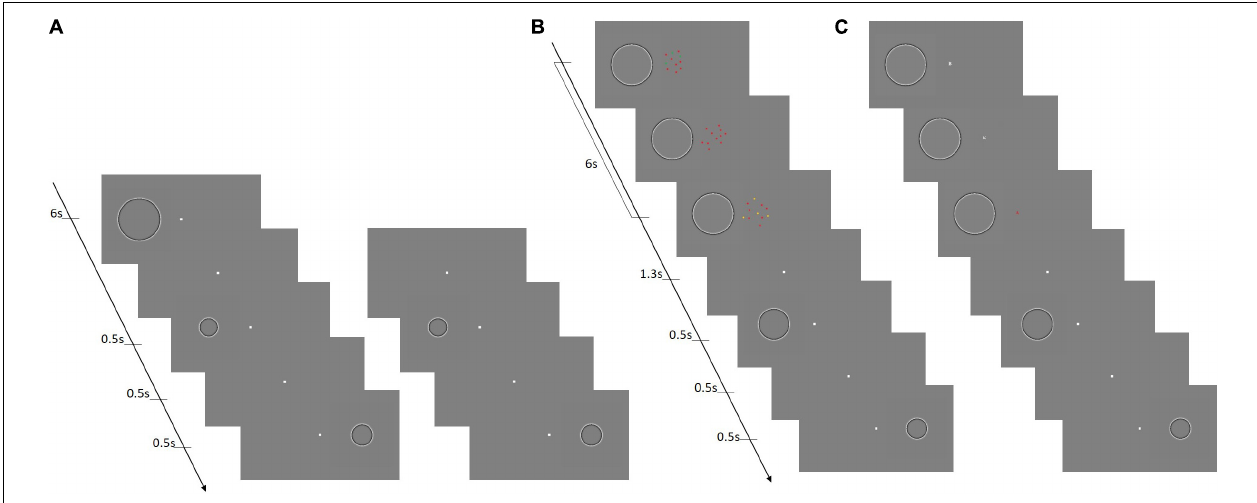
FIGURE 1 | The size discrimination task with and without attentional manipulation. (A) The basic size discrimination task without attentional manipulation. The left and right panels illustrate the adaptation and baseline conditions, respectively. In adaptation condition, first an adapter stimulus was presented on the left of the screen for a duration of 6 s. Subsequently, a test stimulus appeared in the same location followed by a reference stimulus, presented symmetrically on the right side of the screen. The right panel illustrates the sequence of stimuli for the baseline condition where no adapter was presented. (B) The first attentional manipulation comprised a MOT condition, in which the sequence of presentation of the stimuli for the size discrimination was the same as the adaptation condition depicted in (A) (on the left), with the only exception that during the adaptation phase the stimuli used for the MOT task were presented at the fovea. (C) The second type of attentional manipulation consisted of a RSVP condition (presentation sequence identical to left in A ). In this condition, during the adaptation phase the stimuli used for the RSVP task were presented at the